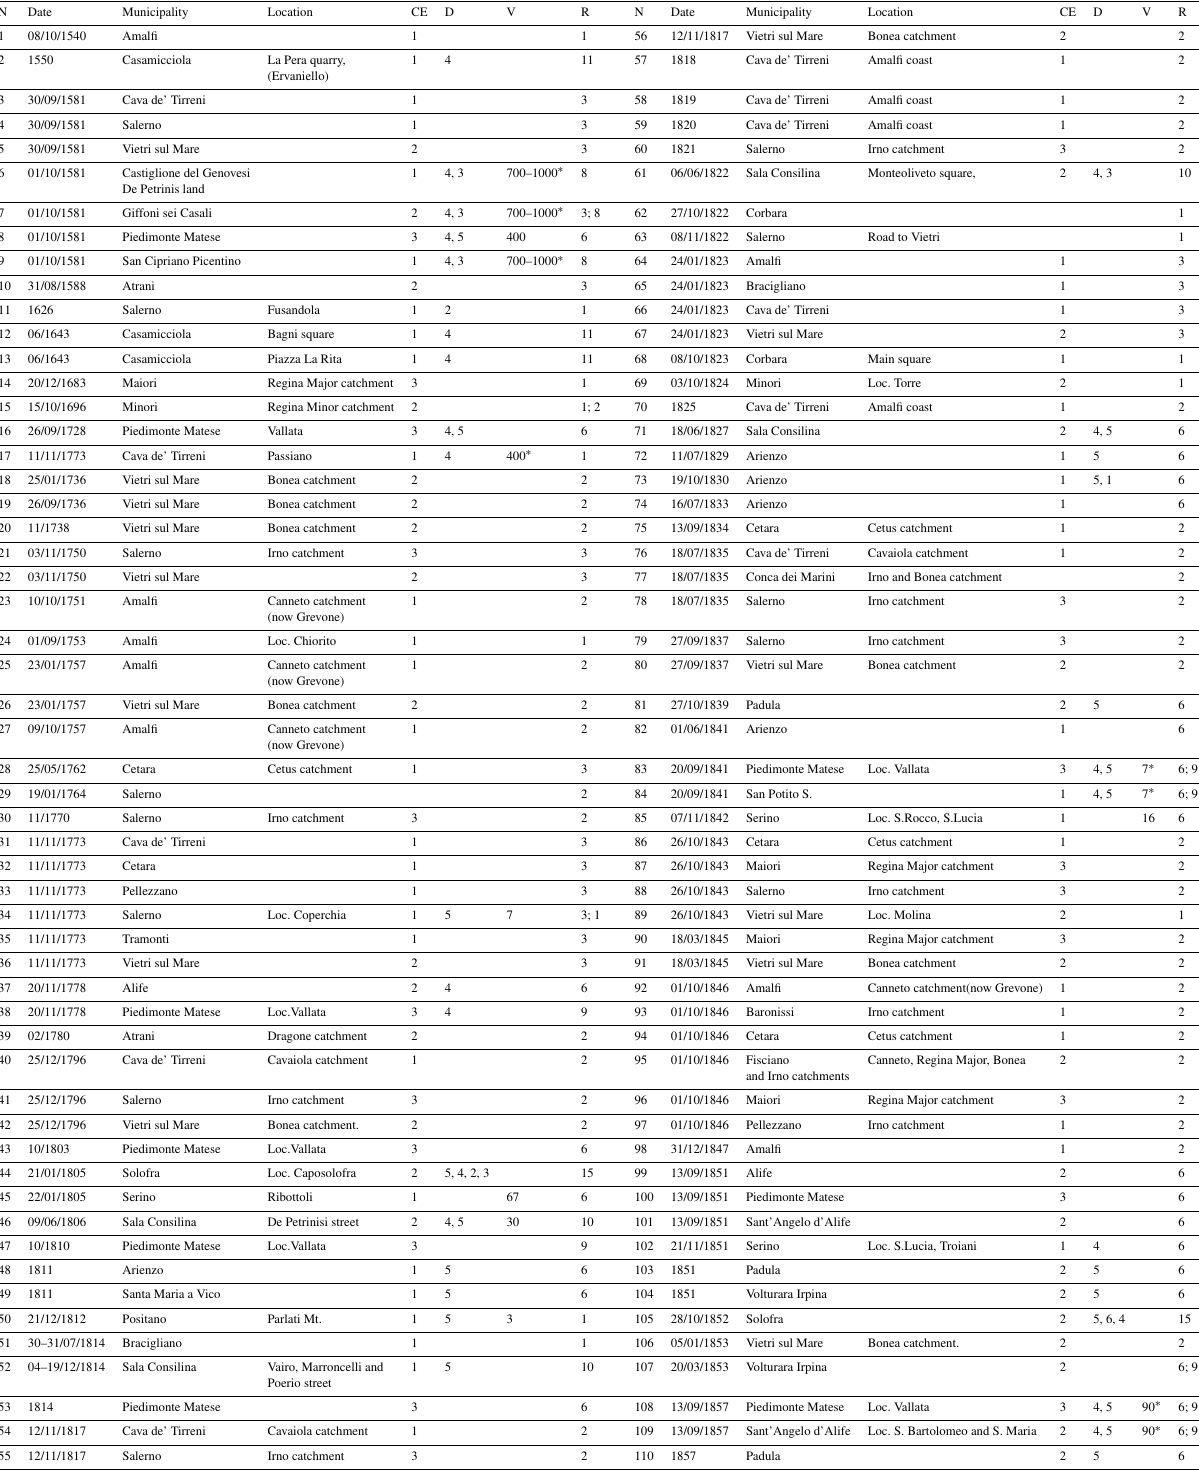
Table 1. N = ID event, date, municipality, location. CE means catchment classes: (1) <3km 2 ; (2) >3 and <10km 2 ; (3) >10 and <60km 2 . D means classes of damaged elements: (1) agricultural land; (2) architectural structures; (3) businesses; (4) private buildings; (5) roads; (6) underground